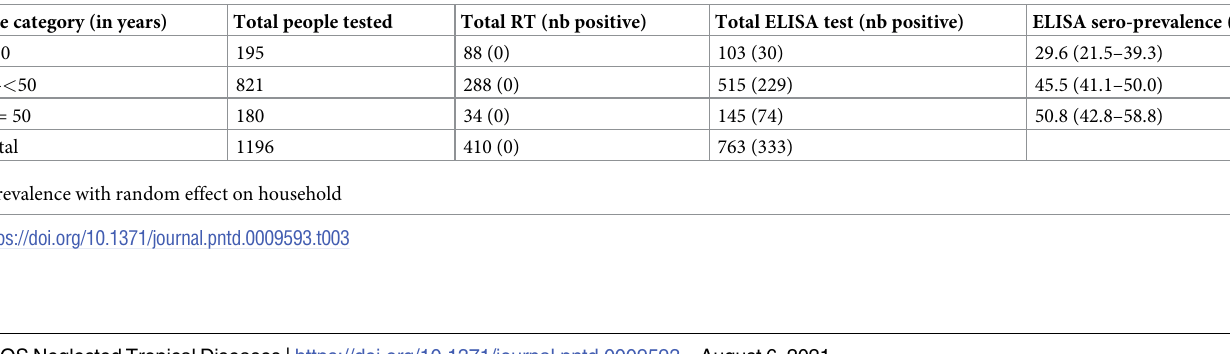
True seroprevalence calculations for humans, goat, sheep and cattle and its comparison with AP are shown in Table 4. Apparent prevalence and TP did not differ much in humans and bovines. In small ruminant, TP was a bit lower than the AP. No correlation between species prevalence was observed at either household or village level (Fig 2). Abortions Abortions were reported overall in 193 out of 4658 animals (4.1%) with a range between 0.0 and 11.5% at Woreda level (Table 2). The majority (85.0%) of livestock that aborted (N = 164/ 193) were ELISA negative. All cattle with abortion history were ELISA negative. A third of camels (N = 1/3; 33.3%), 16.0% (N = 21/132) of goats and 17.0% (N = 8/47) of sheep that had aborted were ELISA positive. Among the two women who had aborted in the last 12 months, one was ELISA positive for brucellosis. The proportion of animals with a history of abortion was significantly higher (OR = 1.66; (Table 5). Table 5 shows the results between brucellosis status and abortion history in the dif- ferent livestock species.